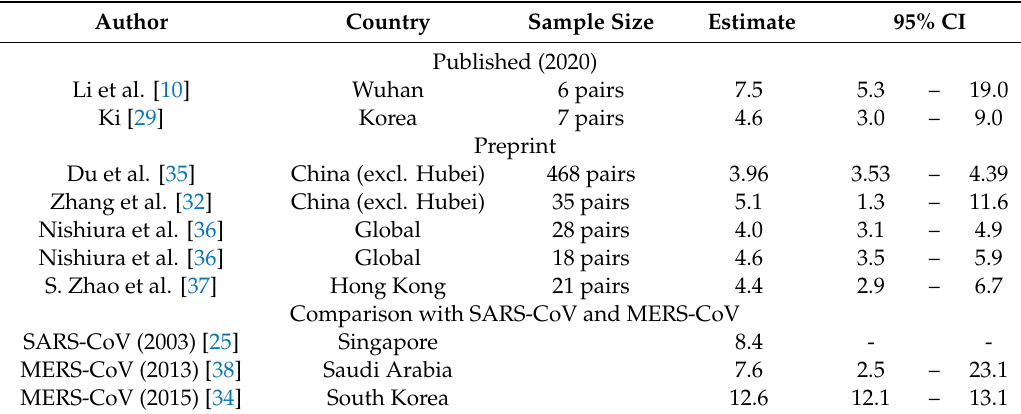
Table 4. Estimated serial interval from selected